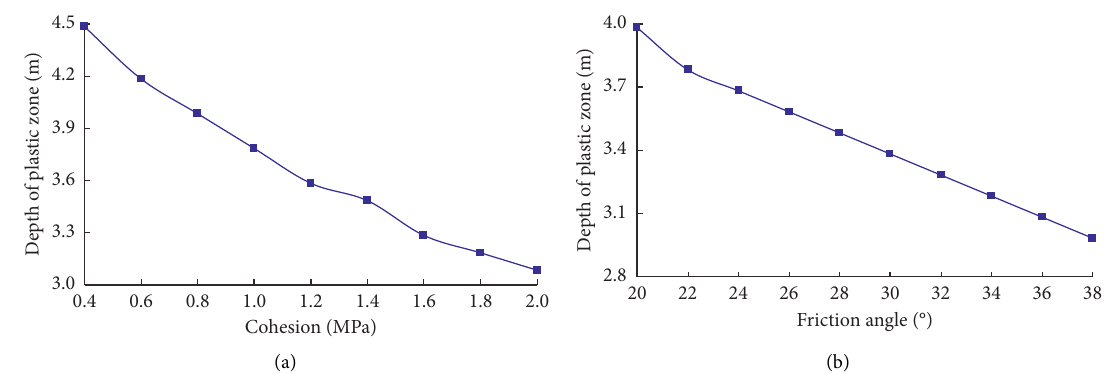
Figure 9: Relationship between the plastic zone of roadway and lithology. (a) Φ � 30 ° . (b) C � 1.2.